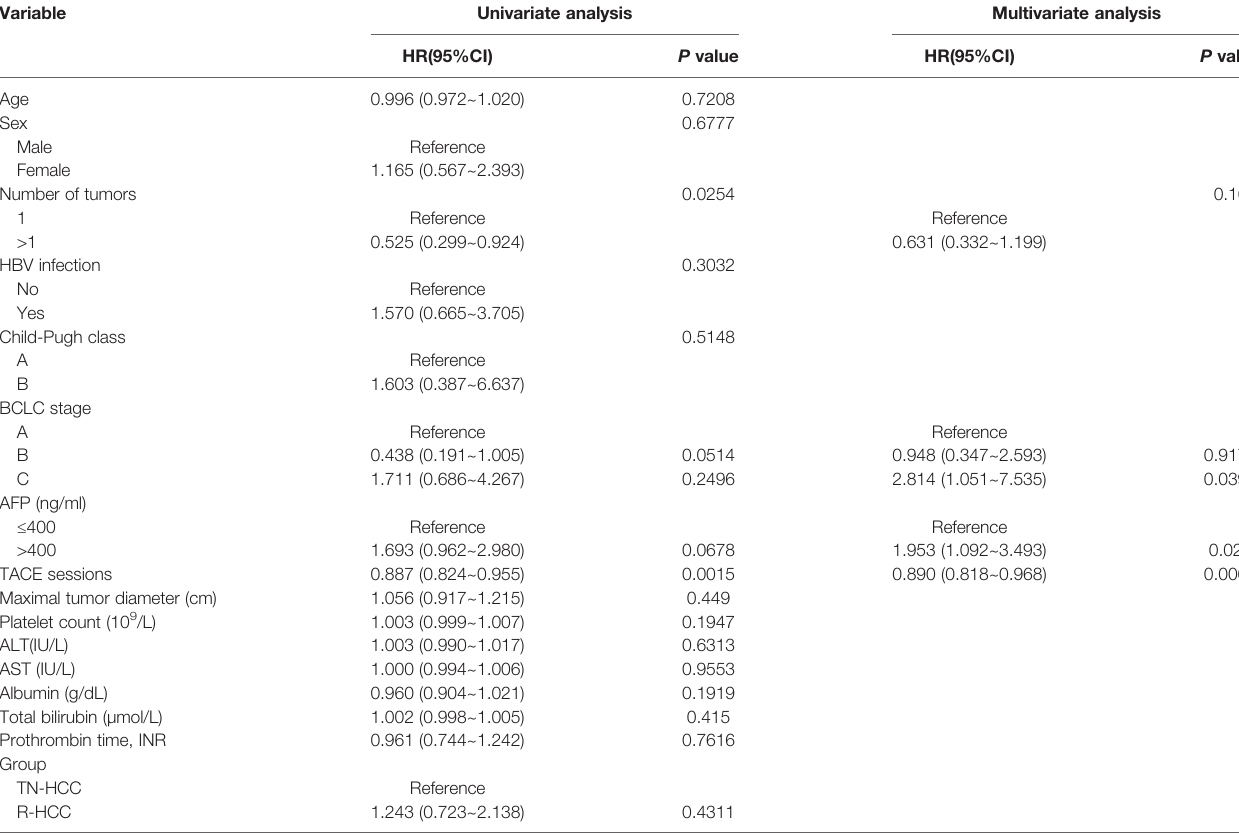
TABLE 2 | Univariate and multivariate analysis of prognostic factors for overall survival (OS) after PSM analysis. Variable Univariate analysis Multivariate analysis HR(95%CI) P value HR(95%CI) P value